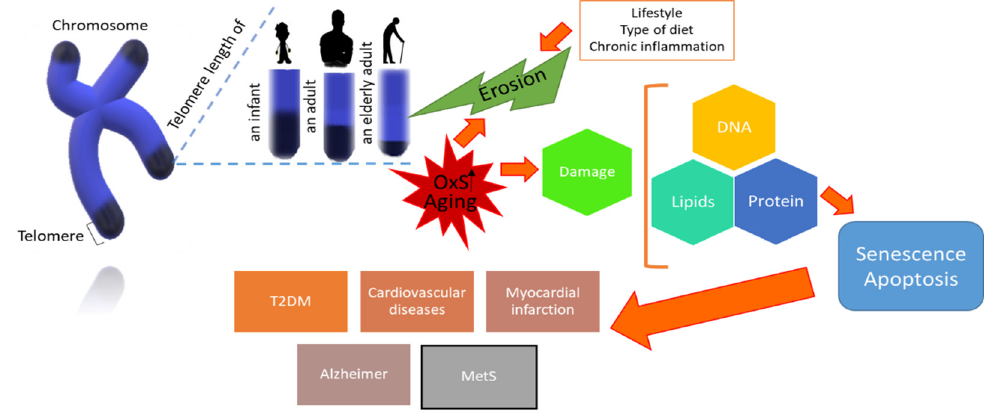
Figure 3. Telomere attrition in aging. OxS and other factors such as lifestyle can cause damage to biomolecules, apoptosis, or senescence, which manifests itself with the appearance of age-related diseases, among them the MetS. OxS: Oxidative Stress; MetS: Metabolic Syndrome.